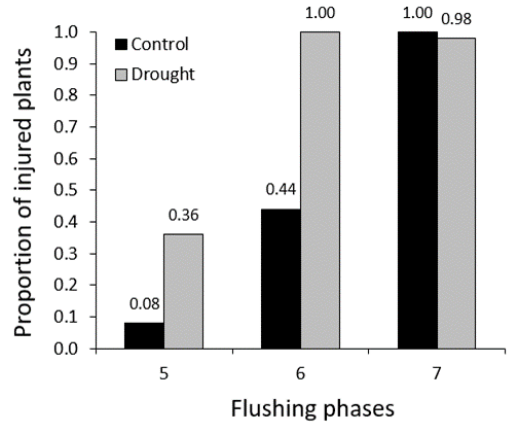
Figure 5. Total proportion of frost-injured plants from all provenances (in the control and drought treatments) that were in flushing phase 5 (leaf unfolding but not yet flattened, small), 6 (leaves still relatively small but with flattened blades, blade edges bent downwards, withered, lighter green or reddish), and 7 (leaves appear completely developed, larger but still more tenderly structured (thinner) than fully developed leaves and lighter green or reddish) at the time of the frost event (on 21st April 2017).